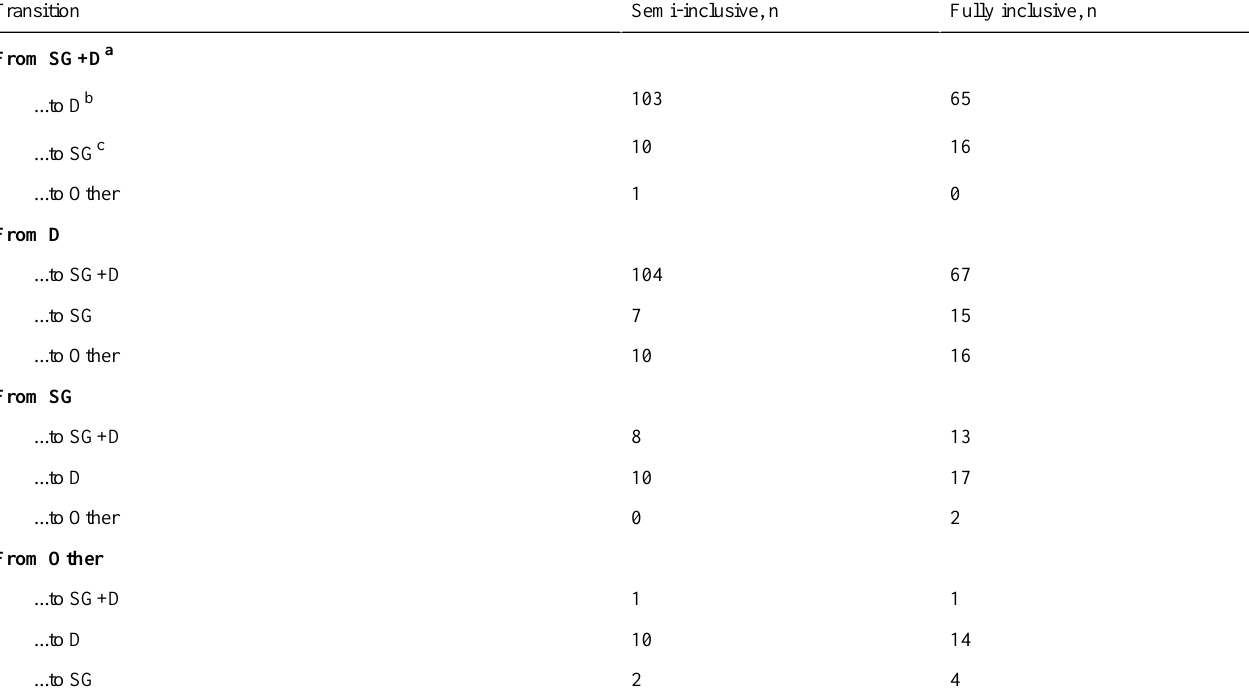
Table 5. Transitions in ground truth data.